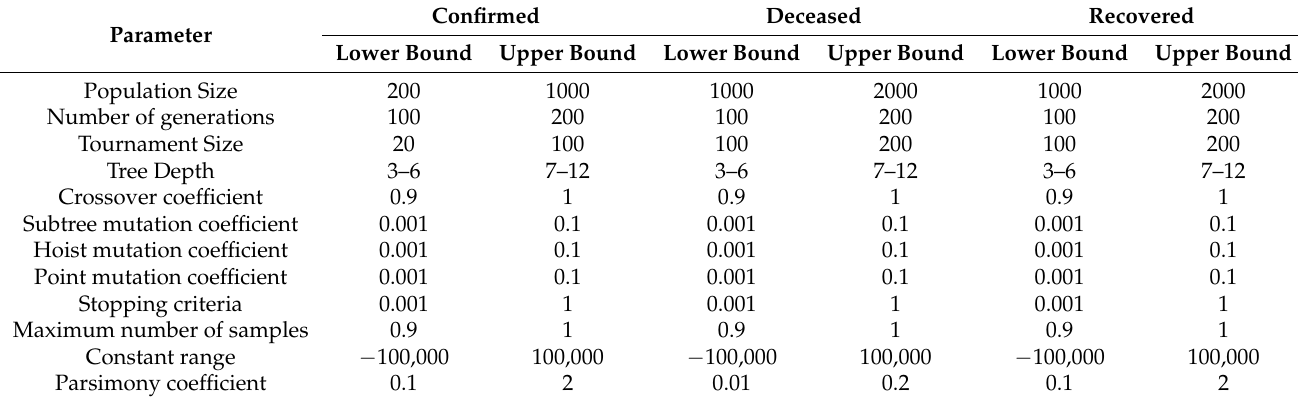
Table 3. The list of GP parameters used to obtain symbolic expressions for the estimation of the number of confirmed patients for each